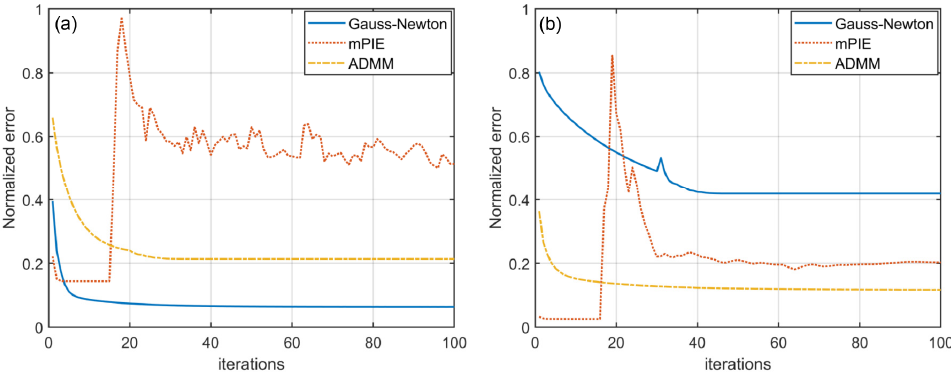
Figure 5. The curves of normalized error metric for three algorithms under ( a ) 50% Gaussian noise and ( b ) Poisson noise ( σ = 10 − 4 ). All algorithms are designed to run for 100 times of